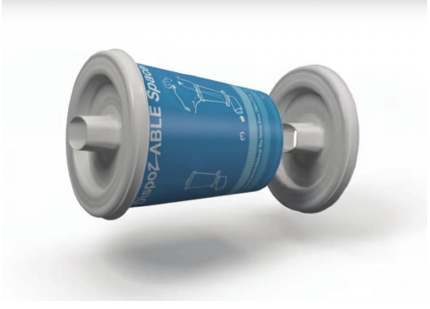
Figure 3: DispozABLE Spacer.